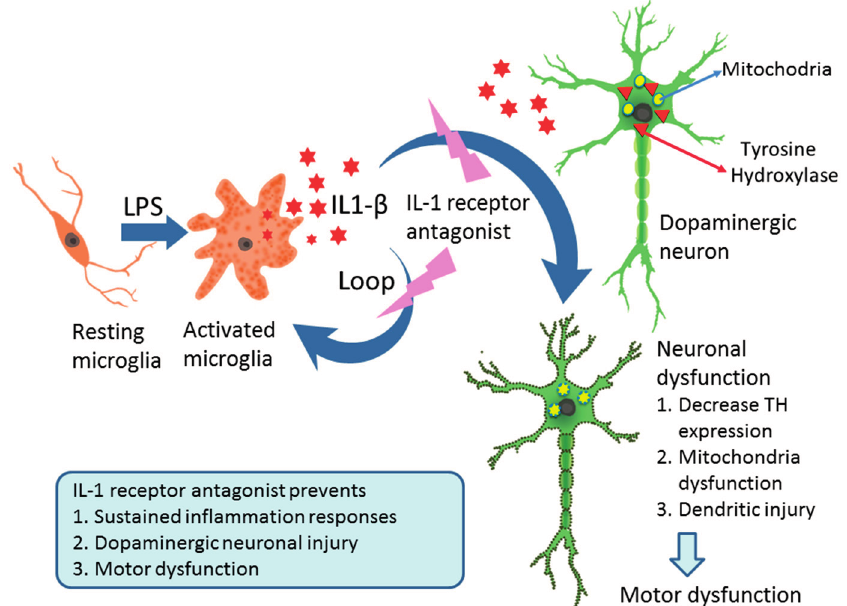
Figure 7. A schematic illustration of the possible mechanisms that underlie chronic neuroinflammation, dopaminergic neuronal injury, and motor behavioral disturbance in LPS-exposed rats at neonatal age. These compromises in both neuronal structures and neurobehaviors were attenuated by IL-1ra, suggesting that IL-1 β plays a critical role in mediating these pathological